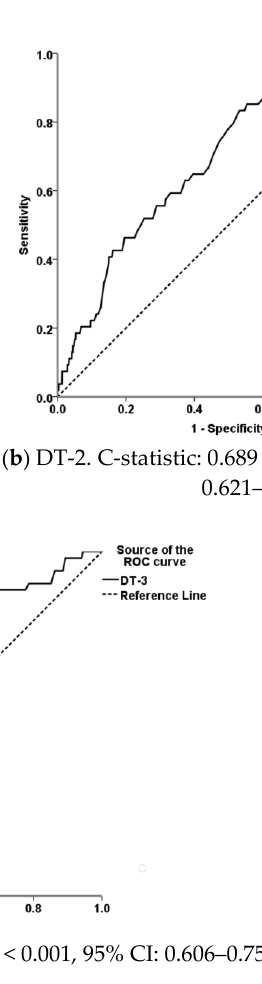
Figure 5. Receiver operating characteristic (ROC) curves illustrating predicted probabilities and the diagnostic performances of the differences between the ambient temperature and the maximum temperatures at ( a ) the coronary band (DT-1), ( b ) the hoof heel (DT-2), and ( c ) the hoof sole (DT-3) as regards footrot; mean values of the areas under the ROC curves (C-statistic ± standard error), statistical significance, and 95% confidence intervals (CI) are also presented.